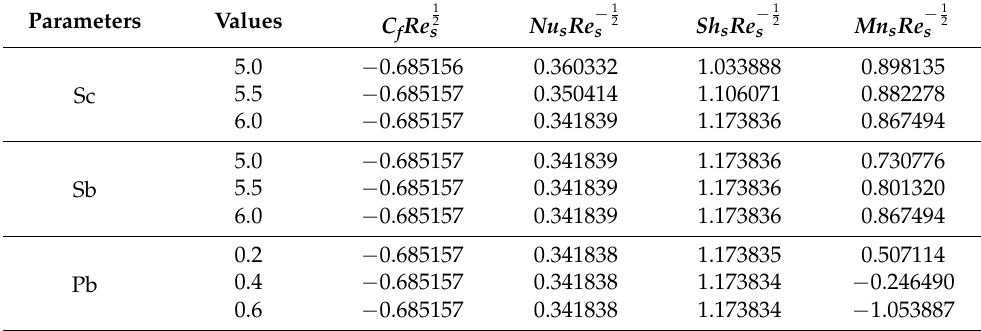
Figure 3. Influence of the curvature parameter on 𝜙(𝜂) and 𝜒(𝜂) .